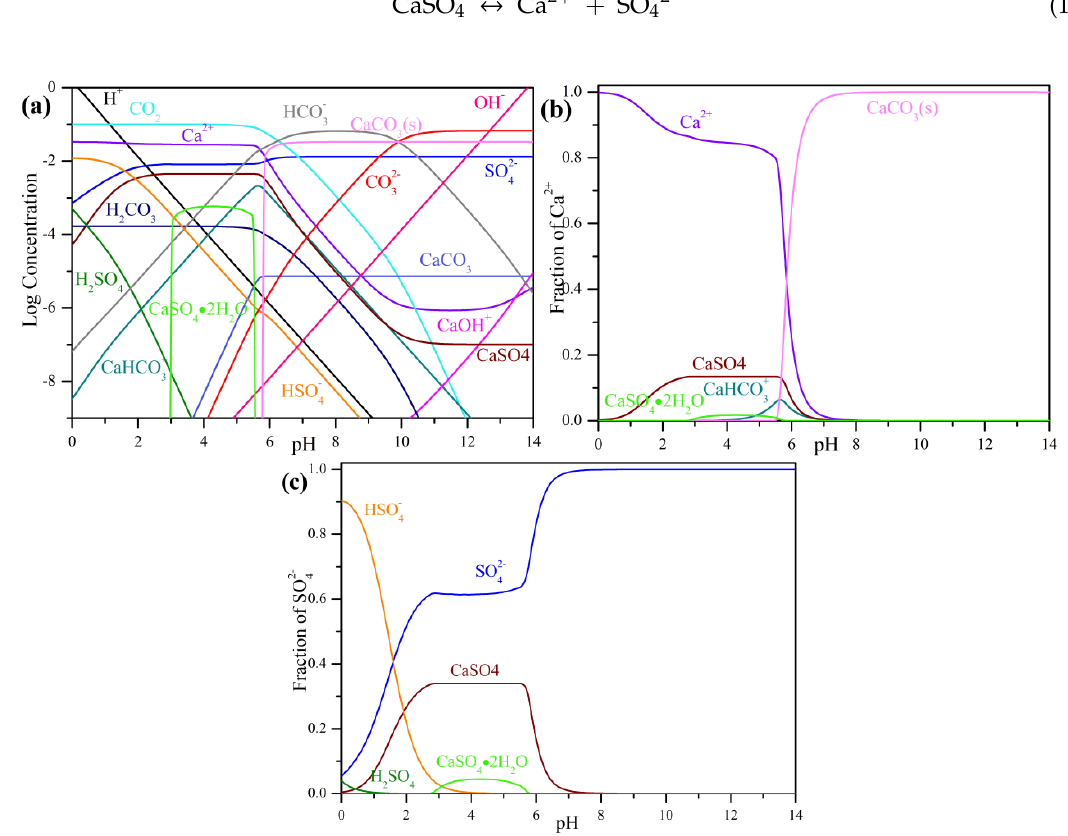
Figure 6. Calculated species distributions of carbonation process with filtration at different pH: ( a ) with log concentration vs. pH; ( b ) with fraction of calcium vs. pH; and ( c ) with fraction of sulfate vs. pH.